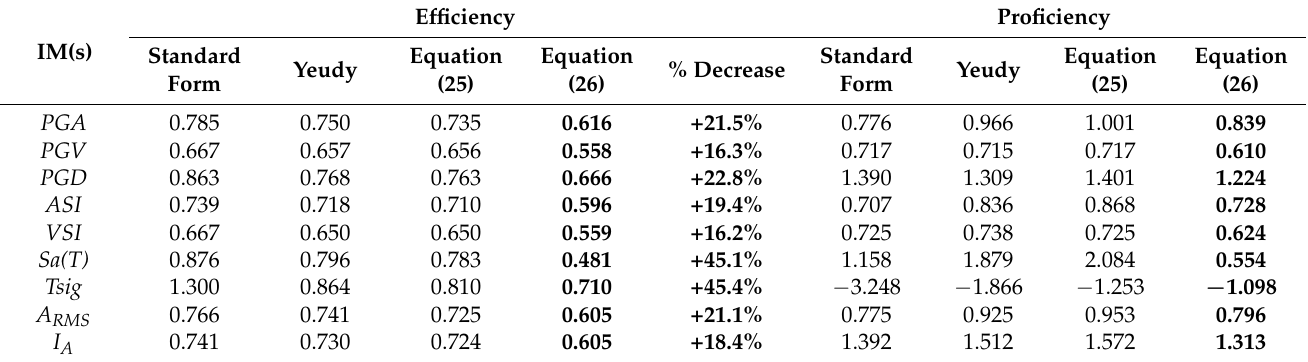
Table 7. Efficiency and proficiency characteristics of various functional forms and IMs.